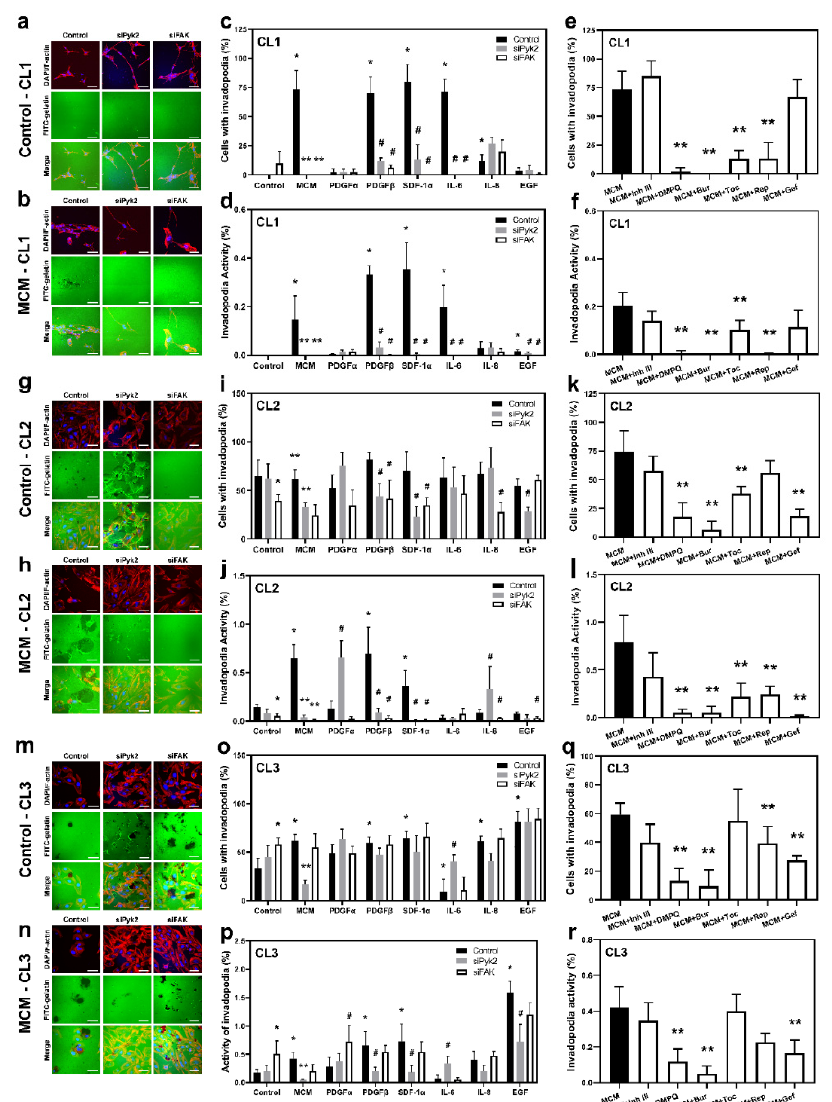
Figure 3. Functional invadopodia formation is enhanced by microglia-derived cytokines and chemokines through Pyk2 and FAK signaling. Fluorescent matrix degradation and invadopodia formation experiments were performed to measure the invasiveness of glioma cells. Representative confocal images of F-actin (rhodamine–phalloidin, red), gelatin (FITC, green), and nuclei (DAPI, blue) under control ( a , g , m ) and microglia-conditioned medium (MCM; ( b , h , n )) conditions are shown for cell lines CL1, CL2, and CL3. Degraded areas of FITC-labeled gelatin are visible as black patches. Oil immersion objectives (40×) were used. Scale bar, 50 μ m. The percentage of cells with invadopodia ( c , e , i , k , o , q ) and invadopodia activity ( d , f , j , l , p , r ) were calculated for control (black bars), after treatment with cytokines in the presence or absence of siPyk2 (gray bars) and siFAK (white bars) and MCM with or without inhibitors. The values are shown as means ± SD for 3–6 experiments per group. * p < 0.05 vs. control, ** p < 0.05 vs. MCM, # p < 0.05 vs. the corresponding cytokine. Inh III, inhibitor III; Bur, burixafor; Toc, tocilizumab; Rep, reparixin; and Gef, gefitinib. Figure 3i demonstrates that none of the cytokines evaluated in CL2 significantly af- fected IF compared with controls. However, PDGF β and SDF-1 α increased the IA by 4.7- and 2.5-fold, respectively, compared with control ( p < 0.05, Figure 3f). This stimulatory effect was abolished by siPyk2 and siFAK (by ≥ 87% for both kinases, p < 0.05), indicating that they are parts of the PDGF β and SDF- α signaling pathways controlling the activity of invadopodia. No significant changes were observed in IF and in AI in the presence of EGF,